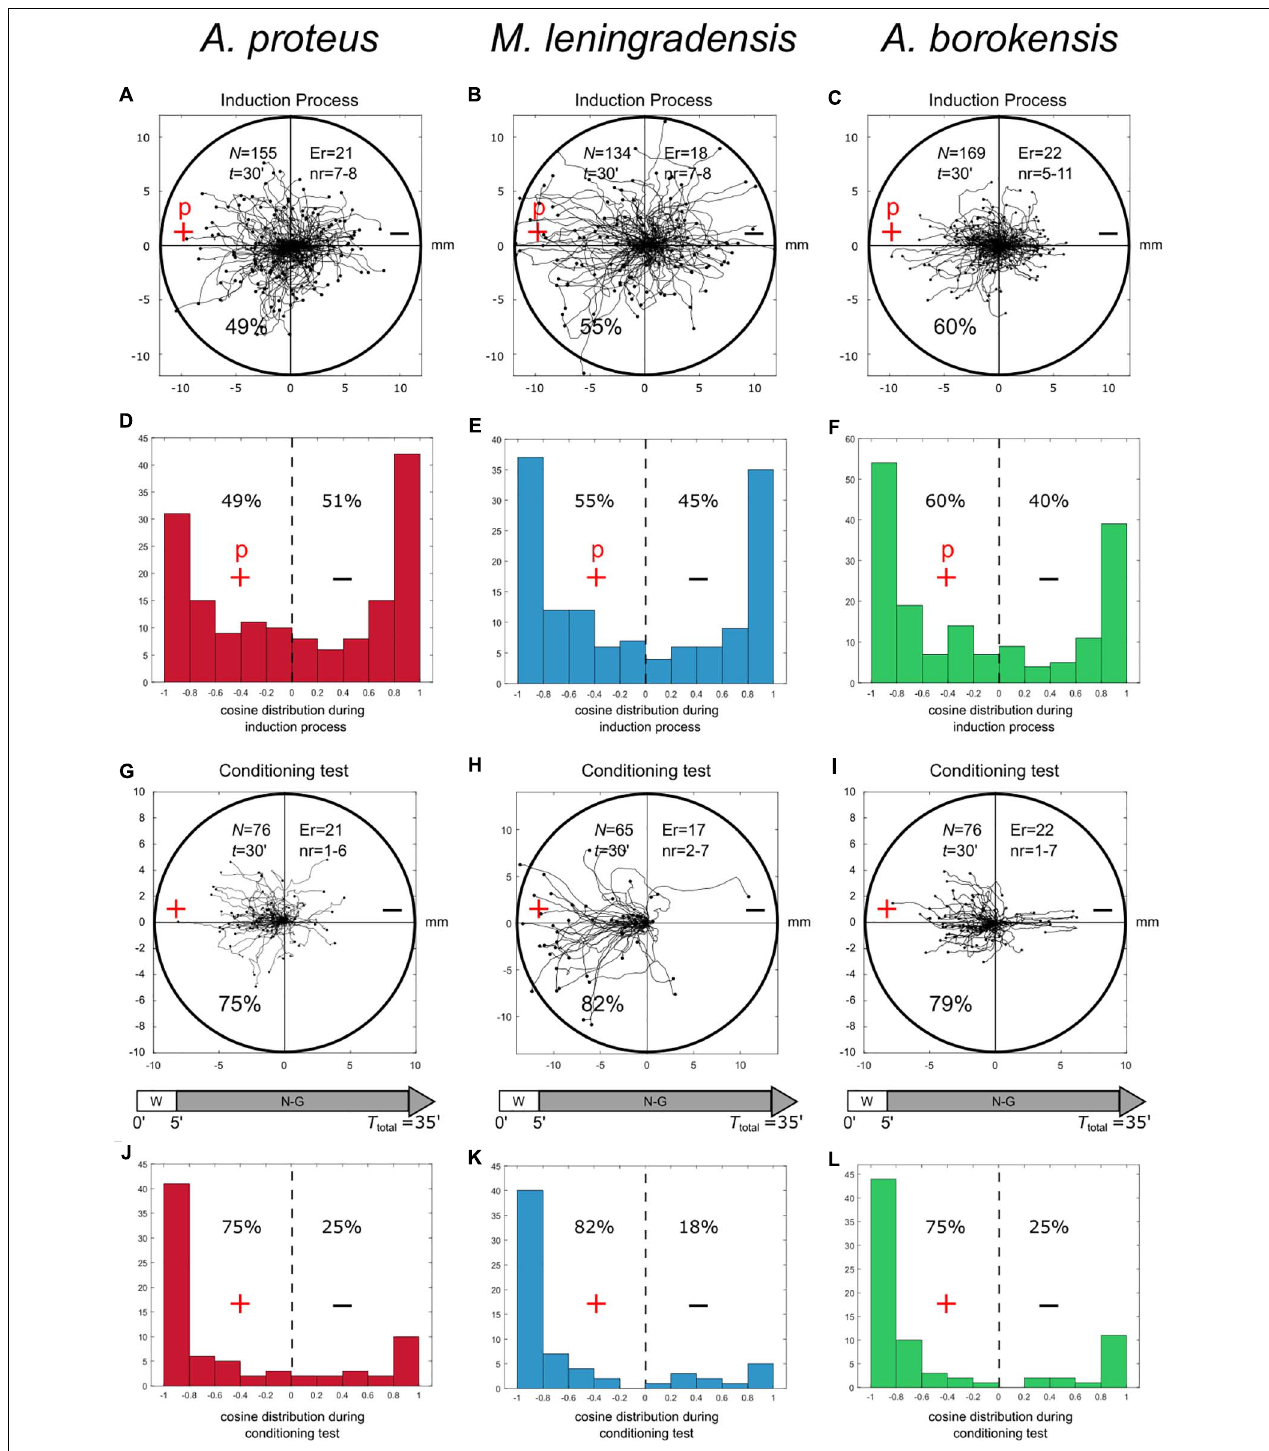
FIGURE 2 | Induction processes and conditioning test. Panels (A–C) show the cellular migration under simultaneous galvanotactic and chemotactic stimuli (induction process) for A. proteus, M. leningradensis , and A. borokensis , respectively. Panels (D–F) illustrate the histograms of the displacement cosines from panels (A–C) , respectively. In panels (G–I) , the trajectories under galvanotactic conditions of those cells that had previously migrated toward the anode-peptide is represented. It can be observed that the 75%, 82%, and 79% of A. proteus, M. leningradensis and A. borokensis cells migrated toward the left positive pole, where the peptide was absent. Panels (J–L) -illustrate the histograms of the displacement cosines from panels (G–I) , respectively. “N” is the total number of cells, “Er” is the experimental replications, “nr” is the number of cells per replication, “t” time of galvanotaxis or chemotaxis, “p” chemotactic peptide (nFMLP), “+” anode, “ − ” cathode. Both the x and y -axis show the distance in mm, and the initial location of each cell has been placed at the center of the diagram.